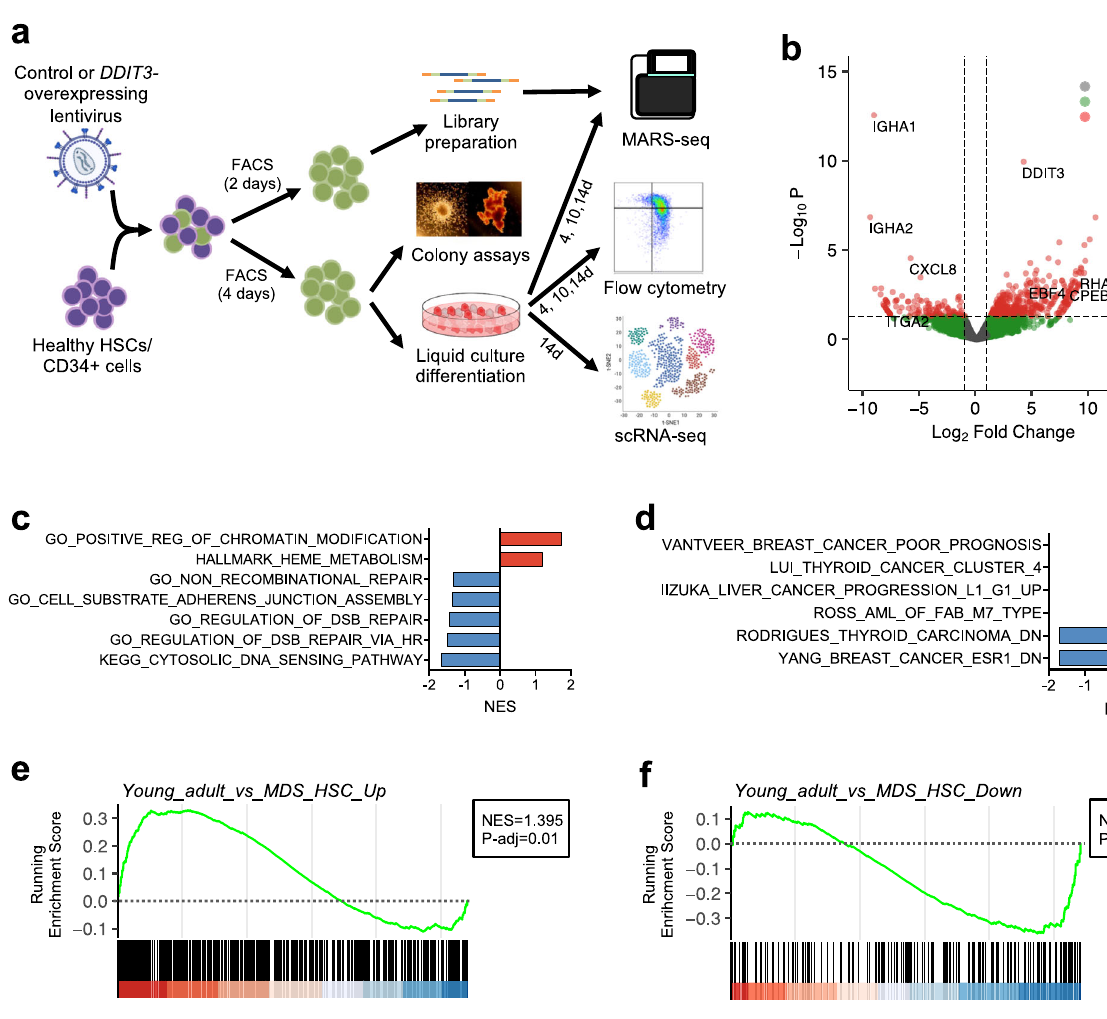
Fig. 3 | DDIT3 overexpression promotes and MDS-like transcriptional state. a Schematic representation of the experimental procedure: primary HSCs/CD34 + cells from healthy young donors were FACS-sorted and infected with a lentiviral plasmid harboring DDIT3 , or a control plasmid. Two days after infection, trans- duced cells were sorted and their transcriptome was analyzed using MARS-seq. After 4 days of infection, transduced cells were also isolated and used to perform colony and liquid culture differentiation assays. The later were evaluated by fl ow cytometry and MARS-seq at different time points and by scRNA-seq at day 14 of differentiation. Part of this fi gure was made in ©BioRender - biorender.com. b Volcanoplotofstatisticalsigni fi cance( − log 10 ( p value))againstfold-change(log 2 Fold-change) of gene expression between cells overexpressing DDIT3 and control